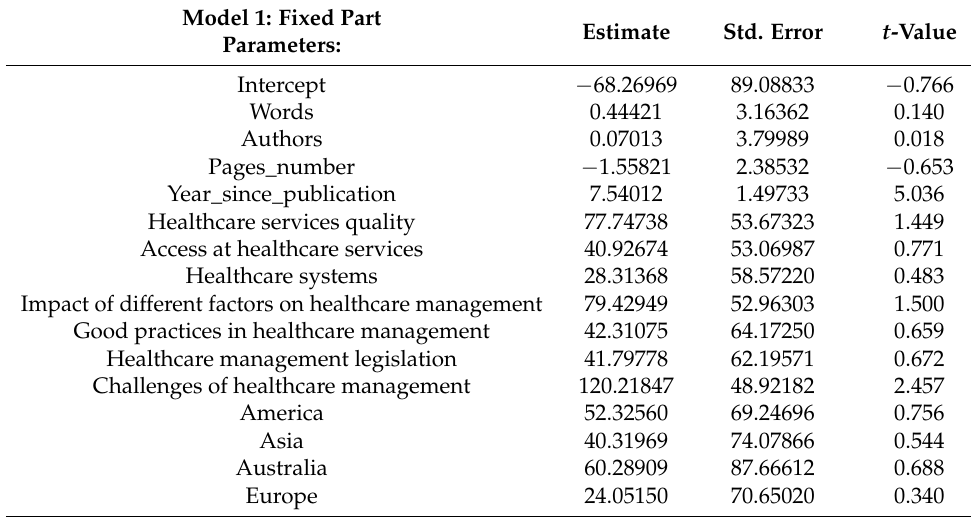
Table 5. The effect of different factors on article citations and a coefficient of random effects according to